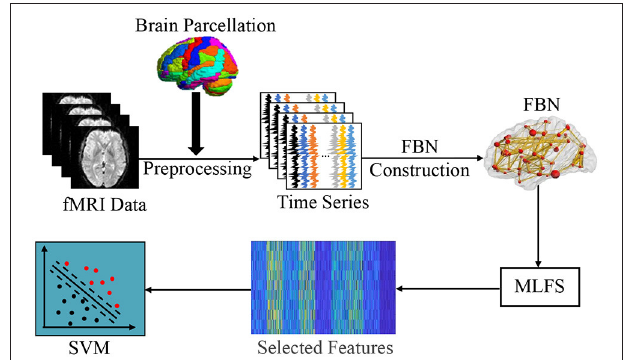
FIGURE 2 | Illustration of the proposed framework for brain disease classification, including three major parts: (1) image pre-processing and FBN construction; (2) feature selection based on MLFS; and (3) classification based on support vector machine (SVM).